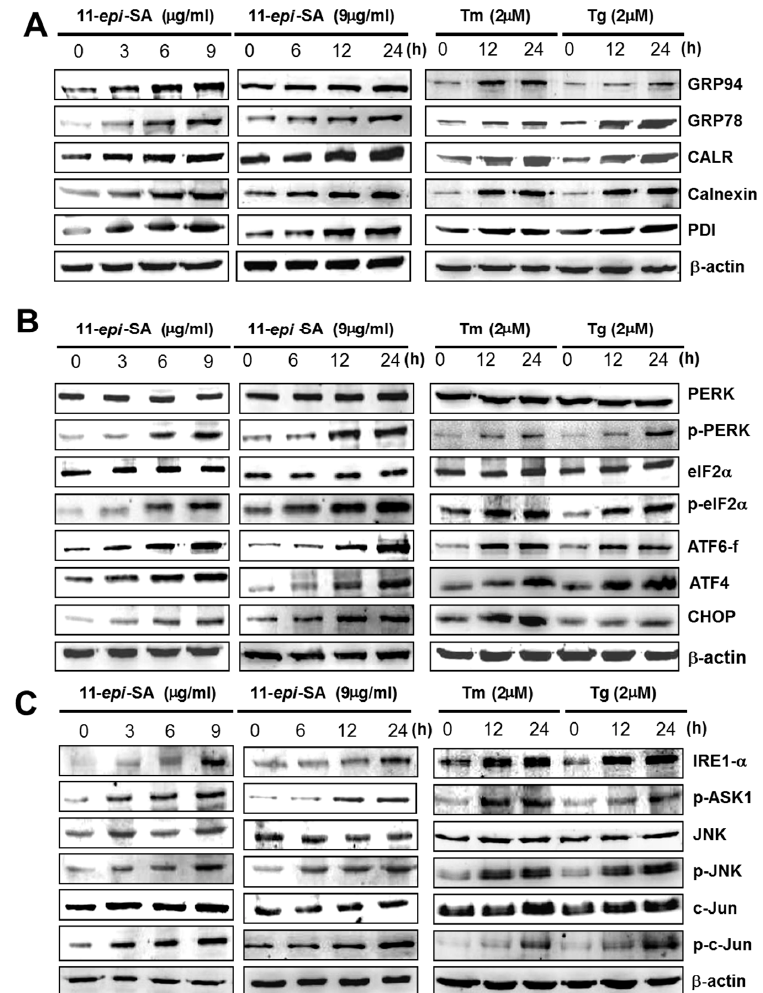
Figure 8. Treatment with 11- epi -SA stimulates the endoplasmic reticulum (ER) stress-mediated apoptotic pathway. HA22T cells were treated without or with 11- epi -SA at different concentrations ( left ) and different time points ( middle ) as indicated. The cells were then harvested to assess the presence ER stress-related apoptotic pathway proteins as indicated. ( A ) ER-related proteins, 94 kDa glucose-regulated protein (GRP94), GRP78/BiP, CALR, calnexin, and PDI were examined by specific antibodies; ( B ) ER stress-mediated apoptotic proteins, protein kinase R (PKR)-like endoplasmic reticulum kinase (PERK), phospho-PERK (p-PERK), eukaryotic initiation factor 2 alpha (eIF2 α ), p-eIF2 α , activating transcription factor (ATF) 6 fragment (ATF6-f), ATF4, and CCAAT/enhancer binding protein (C/EBP) homologous protein (CHOP) were detected by specific antibodies; ( C ) Some other ER stress-related proteins, inositol-requiring enzyme 1 alpha (IRE1- α ), phospho-apoptosis signal-regulating kinase 1 (p-ASK1), c-Jun N-terminal kinase (JNK), phospho-JNK (p-JNK), c-Jun and phosphor-c-Jun (p-c-Jun) were detected by specific antibodies. Please note that cells treated with tunicamycin (Tm) or thapsigargin (Tg) were considered to indicate ER stress response as shown in the right side of each panel.